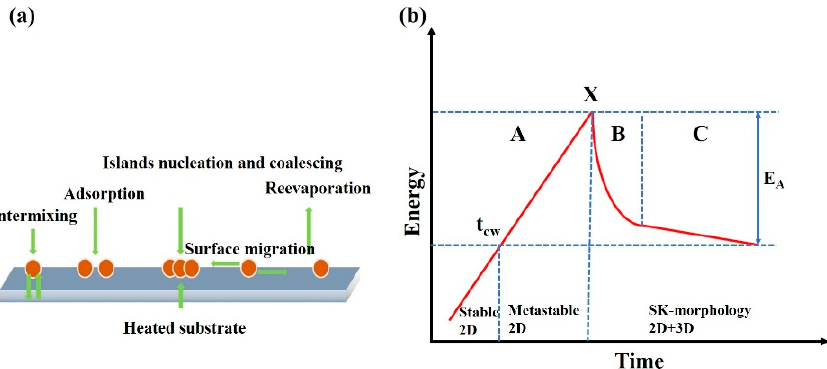
Figure 7. ( a ) Schematics of growth dynamics and ( b ) schematics of total energy versus time for 2D–3D morphology transition.